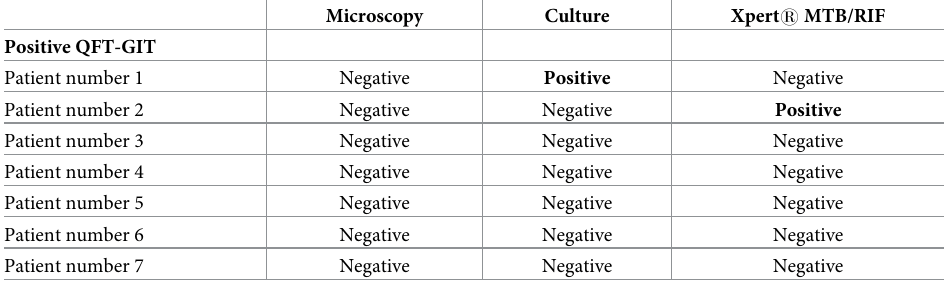
Table 3. Results of the 7 Positive QFT-GIT according of microscopy, culture and Xpert 1